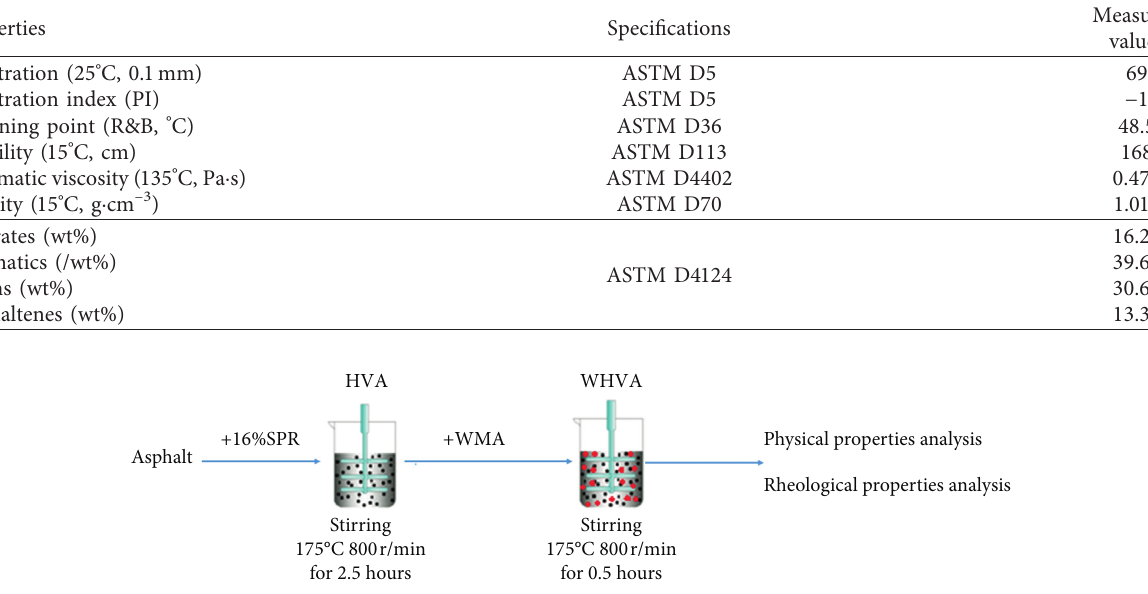
Table 1: Physical properties and chemical compositions of AH-70 asphalt.